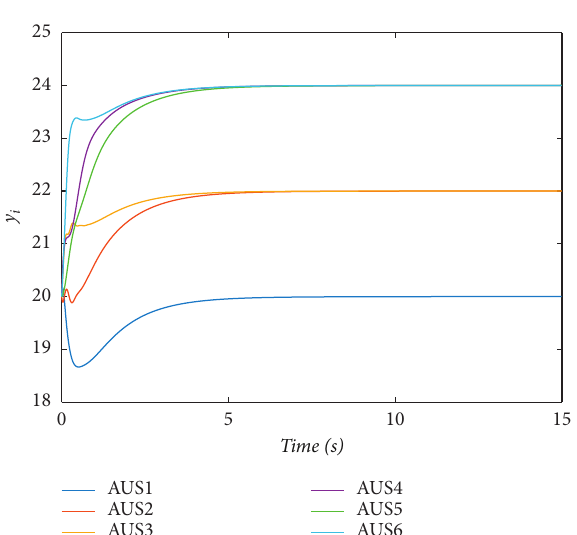
Figure 4: Trajectories of y position of